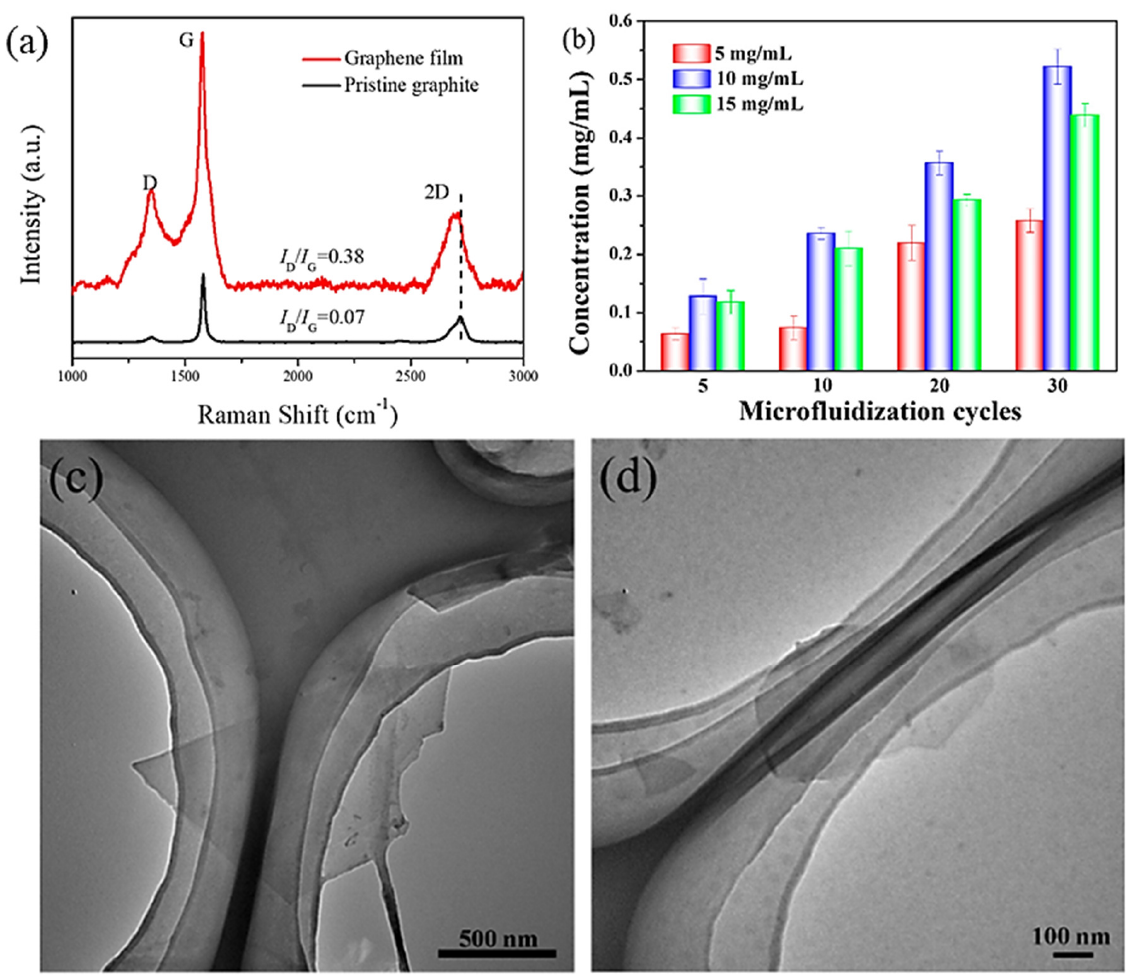
Figure 12. ( a ) Raman spectra of as-prepared graphene and pristine graphite; ( b ) concentration of graphene with the number of microfluidization cycles; and ( c , d ) TEM micrographs after 20 and 30 microfluidization cycles, respectively. Adopted with permission from [88].